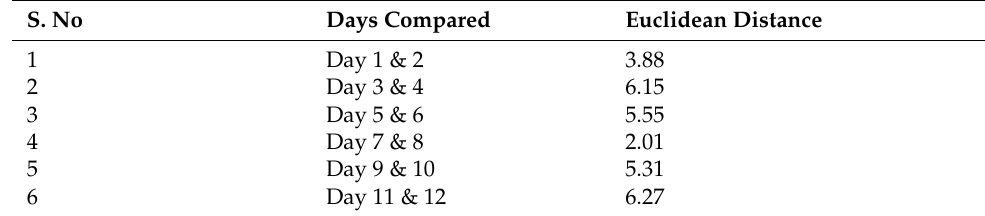
Figure 19. Time-Series Analysis: Motif Discovery between days 9 and 10 of P1. Table 4. Motif Pattern Analysis—Intra patient analysis of